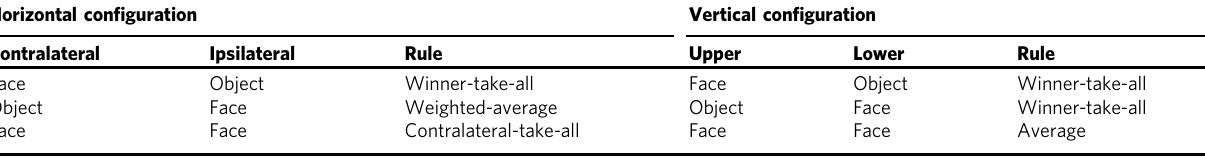
Table 1 Summary of multiple object integration rules in ML across different stimulus